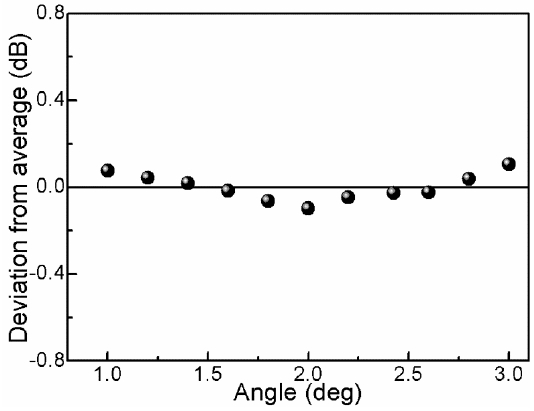
Figure 6. Fringe contrast fluctuation versus bending angle perturbation.